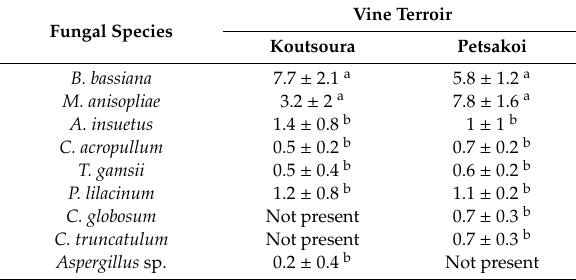
Table 3. The density of colony forming units of fungi (CFU × 10 3 g − 1 ) in soils from vine terroirs in Achaia (F = 2.396, df = 5, P = 0.032). Mean ± sd values with the same letter within a column are not significantly di ff erent (P <